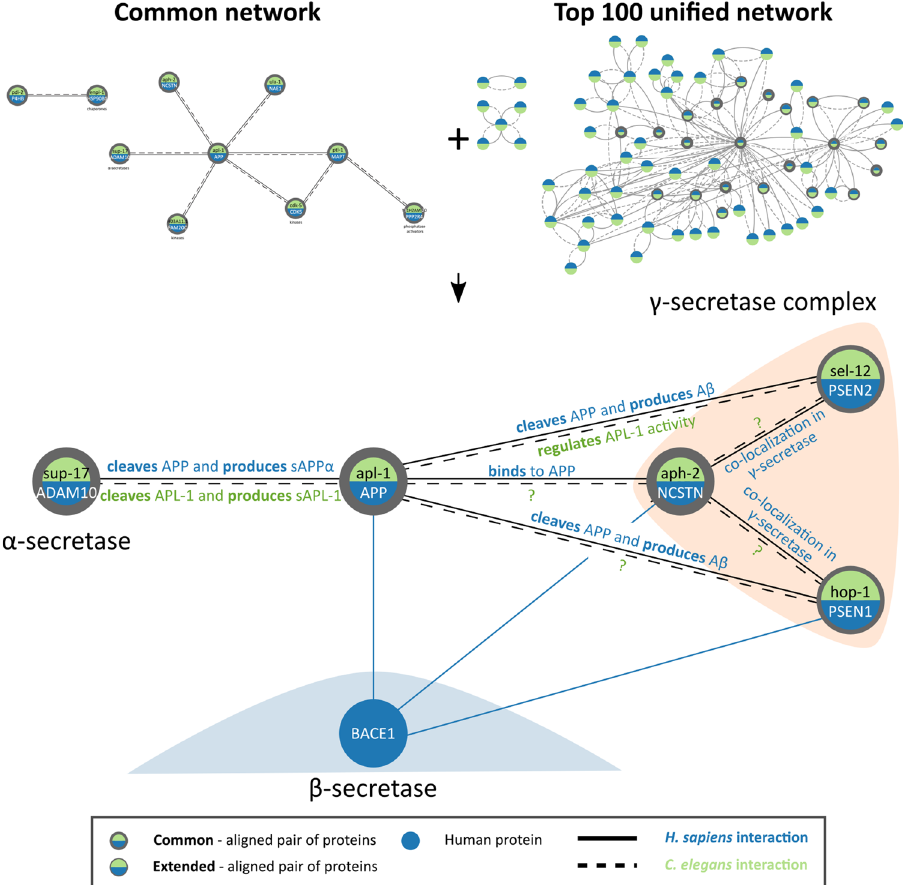
Figure 3. Conservation of the APP processing pathway in H. sapiens and C. elegans . Shown here are elements of the APP processing pathway found in the Common Network , extended with relevant proteins and interactions from the “ Top 100 interaction partners ” dataset. Elements associated with α- and γ-secretase activity are conserved in both organisms, while β-secretase is missing from C. elegans . Even though all interactions that take place in this pathway have been experimentally investigated in human, information related to AD could be retrieved only for two C. elegans